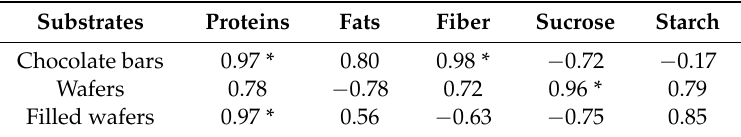
Table 4. Pearson’s linear correlation coefficient between methane yields and chemical composition of